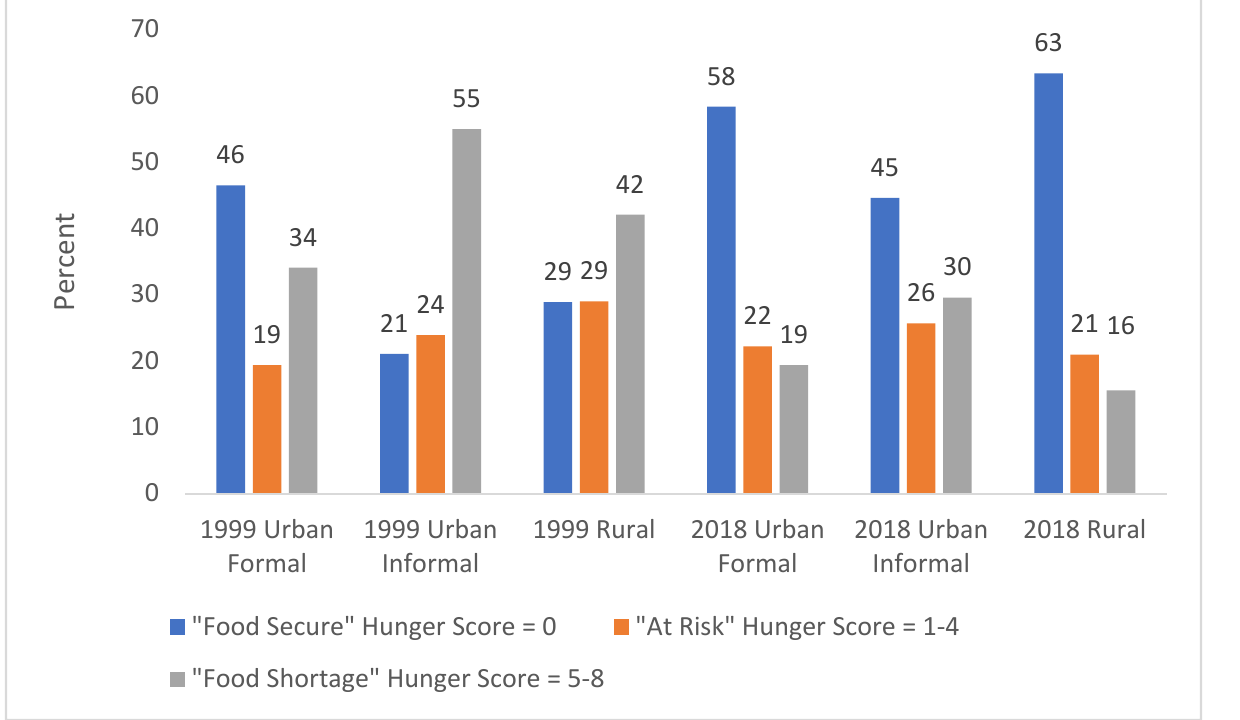
Figure 1. Percent households with different hunger scale categories in Gauteng (values rounded to nearest whole number).